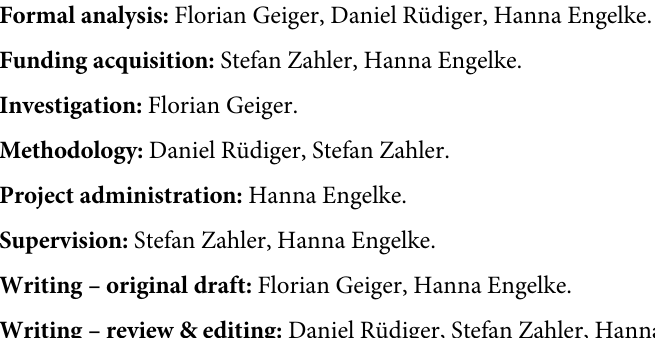
S5 Fig. Fraction of phenotypes depending on pore size. a) fraction of cells in respective pore size with pseudopodial phenotype, 4 μ m binning, ( � p < 0.01, �� p < 0.02, ��� p < 0.1); b) frac- tion of cells in respective pore size with round phenotype, 4 μ m binning, ( � p < 0.1, �� p <